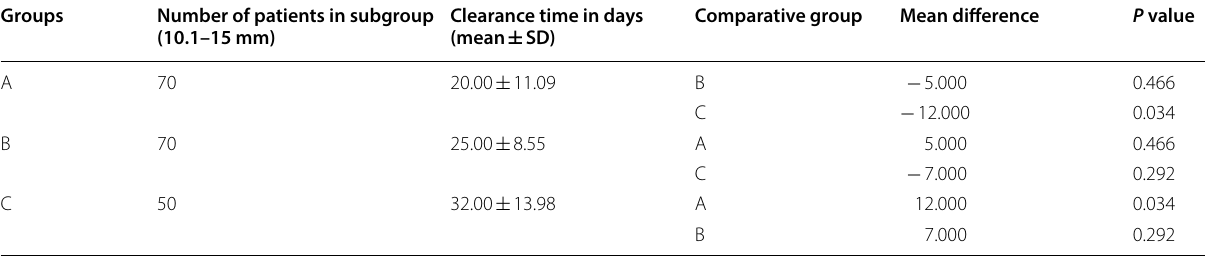
Table 7 Subgroup (10.1–15 mm) analysis of stone clearance time